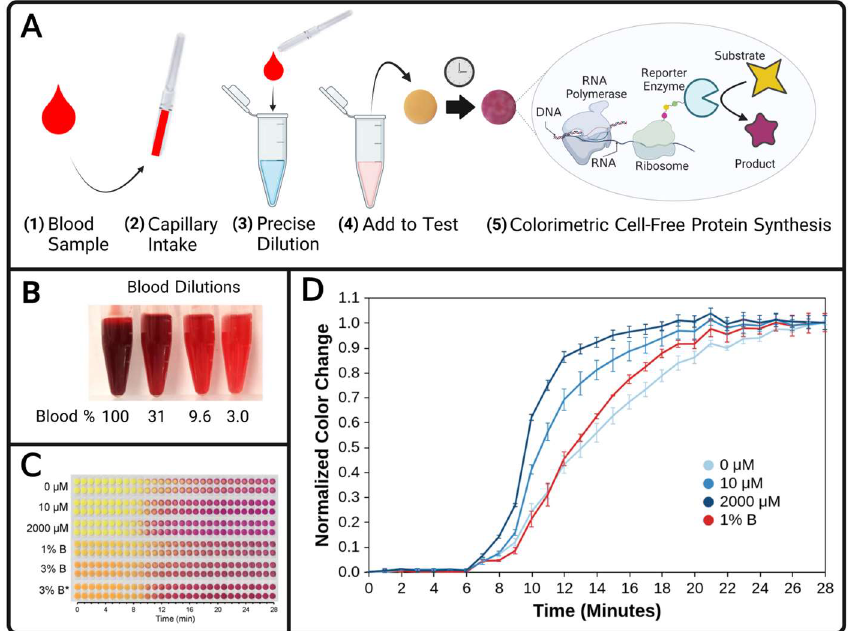
Figure 2. A method of at-home blood dilution compatible with CFPS biosensing reactions. ( A ) Workflow of a CFPS blood dilution diagnostic. Blood is collected, diluted, and then used to hydrate a prepared CFPS reaction wherein the coupled transcription and translation of the β-galactosidase reporter enzyme converts the yellow substrate, chlorophenol red β-D galactopyranoside (CRPG), to the purple product chlorophenol red. ( B ) Serial 3.22-fold dilutions of human blood from left to right. The percentages indicate the blood concentration (% v/v ) in deionized water. ( C ) Reaction time-course photographs of a glutamine biosensor and various samples and standard reactions. Glutamine-deficient CFPS reagents lyophilized on paper are hydrated with 12 µ L of fluid. The top 3 labels with concentrations, in µ M, indicate the glutamine concentrations in aqueous standards. The bottom 3 labels with percentages indicate a blood volume ratio, diluted in water. The 3% B* indicates a 3% blood dilution sample that was spiked with 2000 µM of added glutamine. Each condition was performed in duplicate and the photographs of duplicates were arranged in adjacent rows, where each row represents repeated photographs of the same reaction paper. ( D ) Quantitative analysis of sensing reaction photographs for selected conditions from C. The average color for each circular reaction paper at each time point was quantified in CIELAB color space and normalized to the starting and ending values within each row. For each time point, the average of replicates for each condition was plotted with interpolating lines. The standard deviation for each set of duplicate reactions is displayed as error bars. A plot with the individual data points can be found in Supplementary Figure S6 and a plot including quantification for 3% B and 3% B* is included in Supplementary Figure S1.